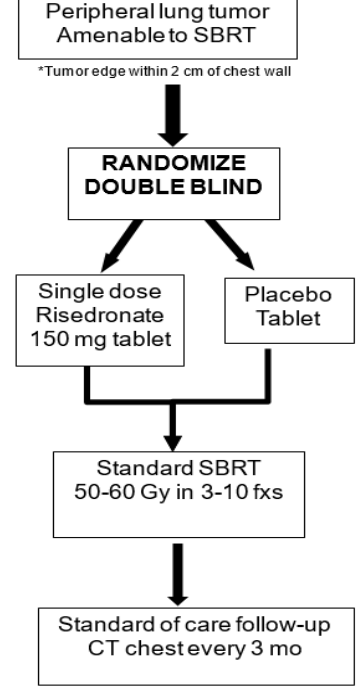
Figure 3. Study Schema. SBRT, stereotactic body radiotherapy. Placebo = methylcellulose; Study drug to be given approximately 10 days prior to SBRT start.